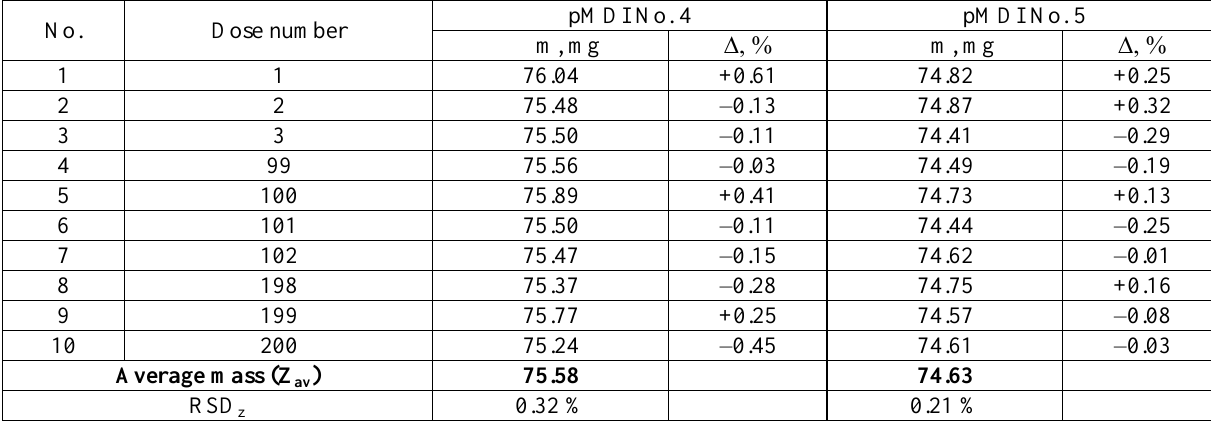
The results of the tests in regard to dose mass (m) and uniformity of dose for the pMDIs with beclometasone